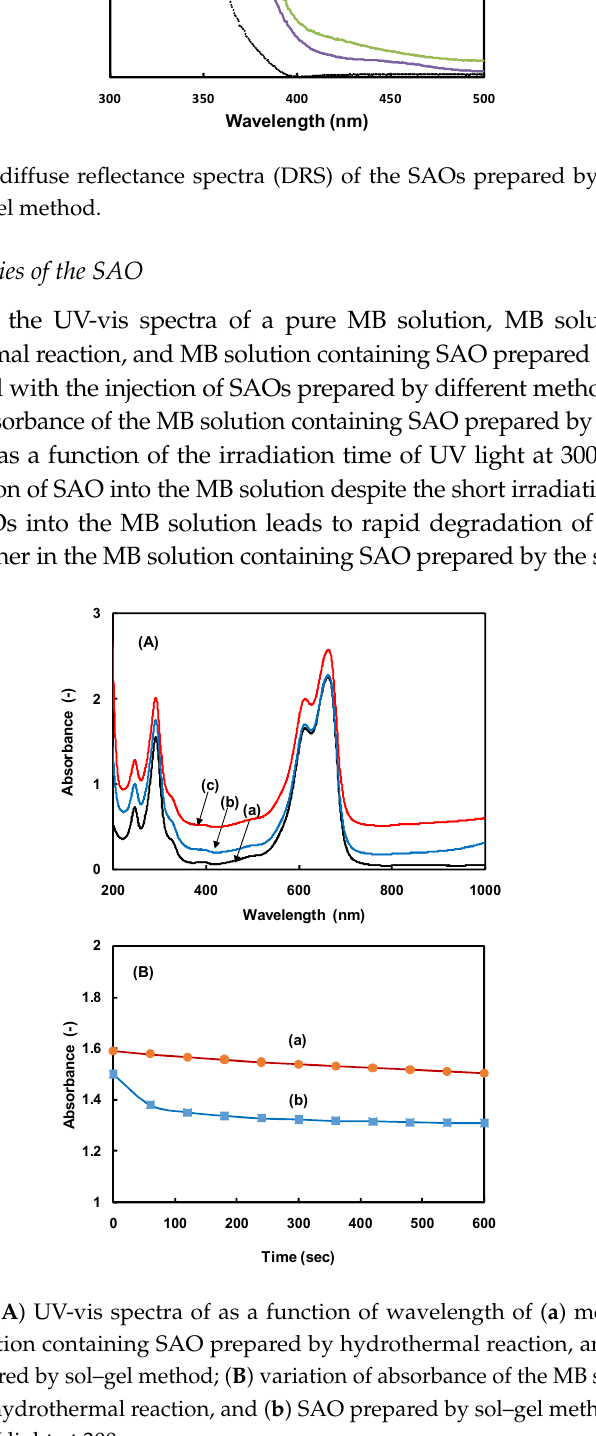
Figure 8. Results of ( A ) UV-vis spectra of as a function of wavelength of ( a ) methylene blue(MB) solution, ( b ) MB solution containing SAO prepared by hydrothermal reaction, and ( c ) MB solution